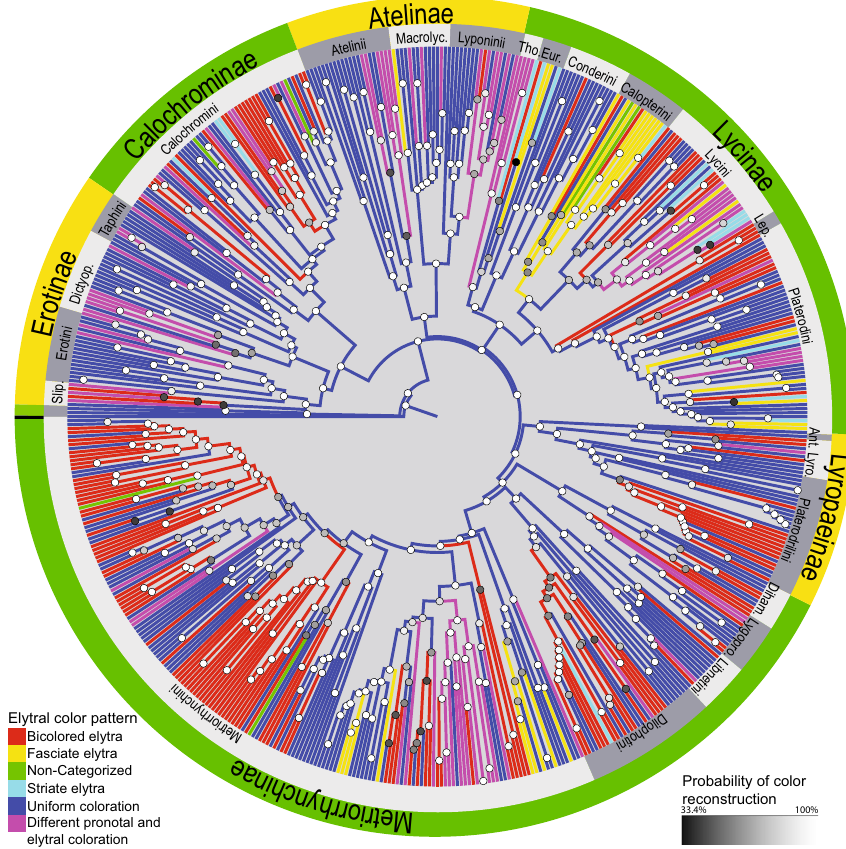
Figure 7. The Bayesian reconstruction of the net-winged beetle colouration. The full resolution tree is available in Fig. S918. The figure was produced in a whole by authors listed under the title of this